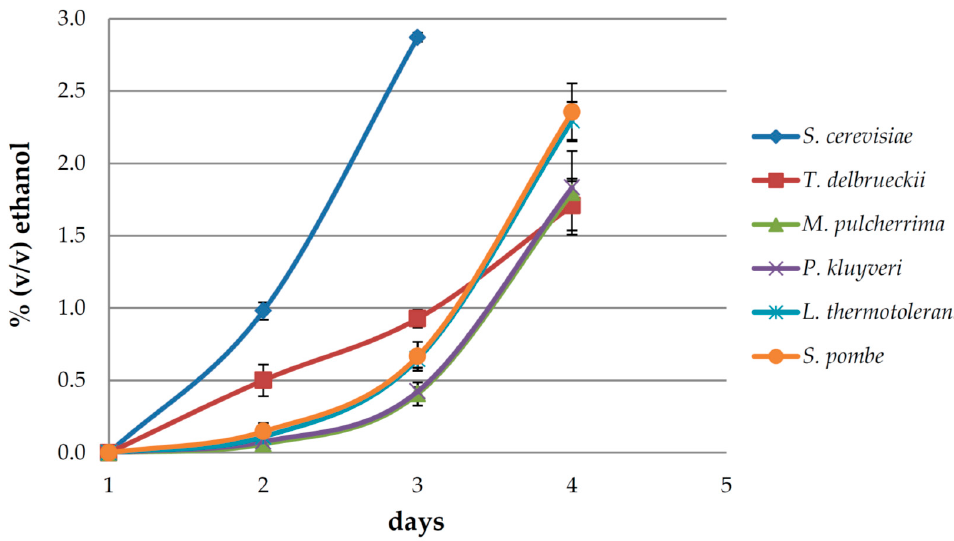
Figure 1. Ethanol production over time in early fermentation of Malvazija istarska ( Vitis vinifera L.) white grape must inoculated with Saccharomyces cerevisiae and five non- Saccharomyces yeasts: Torulaspora delbrueckii , Metschnikowia pulcherrima , Pichia kluyveri , Lachancea thermotolerans , and Schizosaccharomyces pombe .